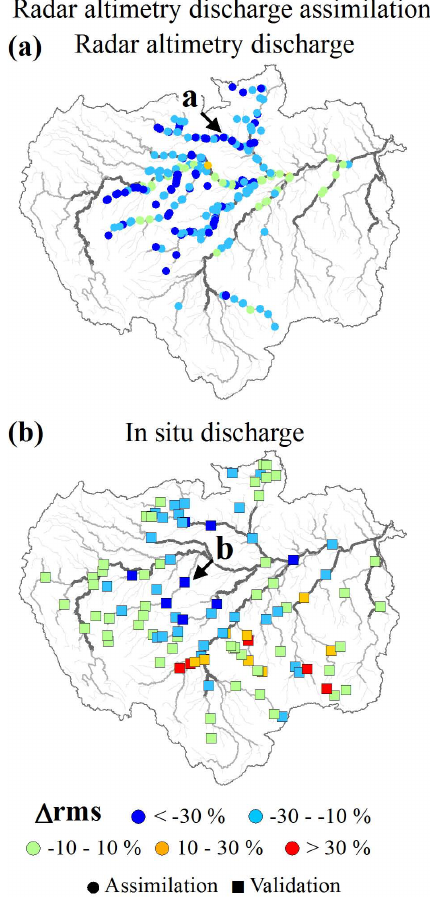
Fig. 6. Evaluation of ENVISAT radar altimetry discharge assim- ilation. Spatial distribution of change in root-mean-square error ( 1 rms) at (a) altimetry stations used for data assimilation and (b) stream gauges with discharge data used for